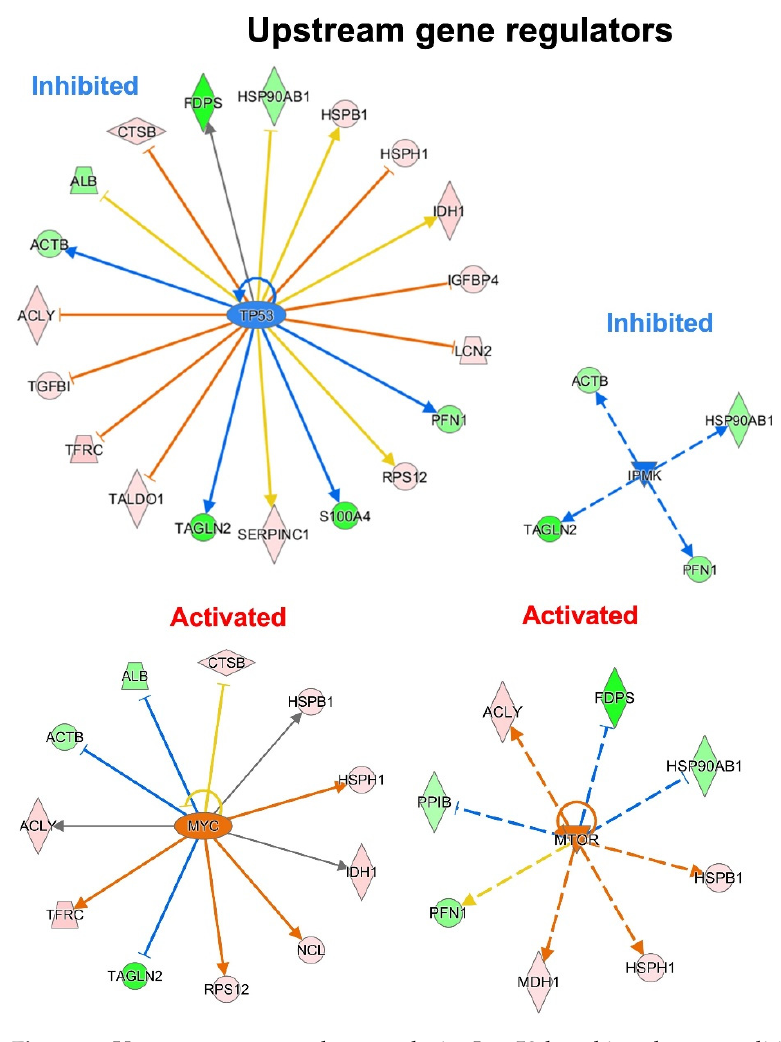
Figure 6. Upstream gene regulator analysis. In p53 knocking-down conditions, TP53 and IPMK are the most significant inhibited upstream regulators, while MYC and MTOR resulted the most significant activated regulators.